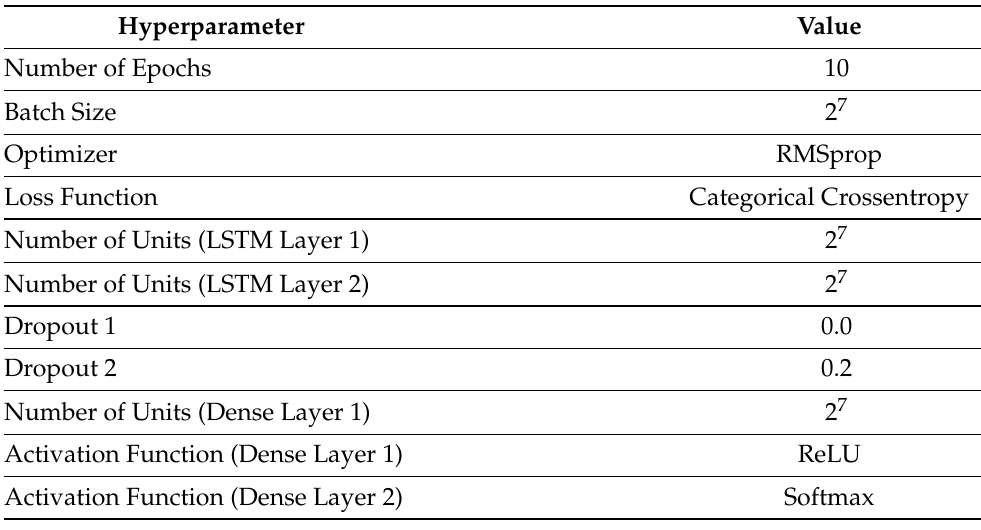
Table 11. Used hyperparameters for the training of the best